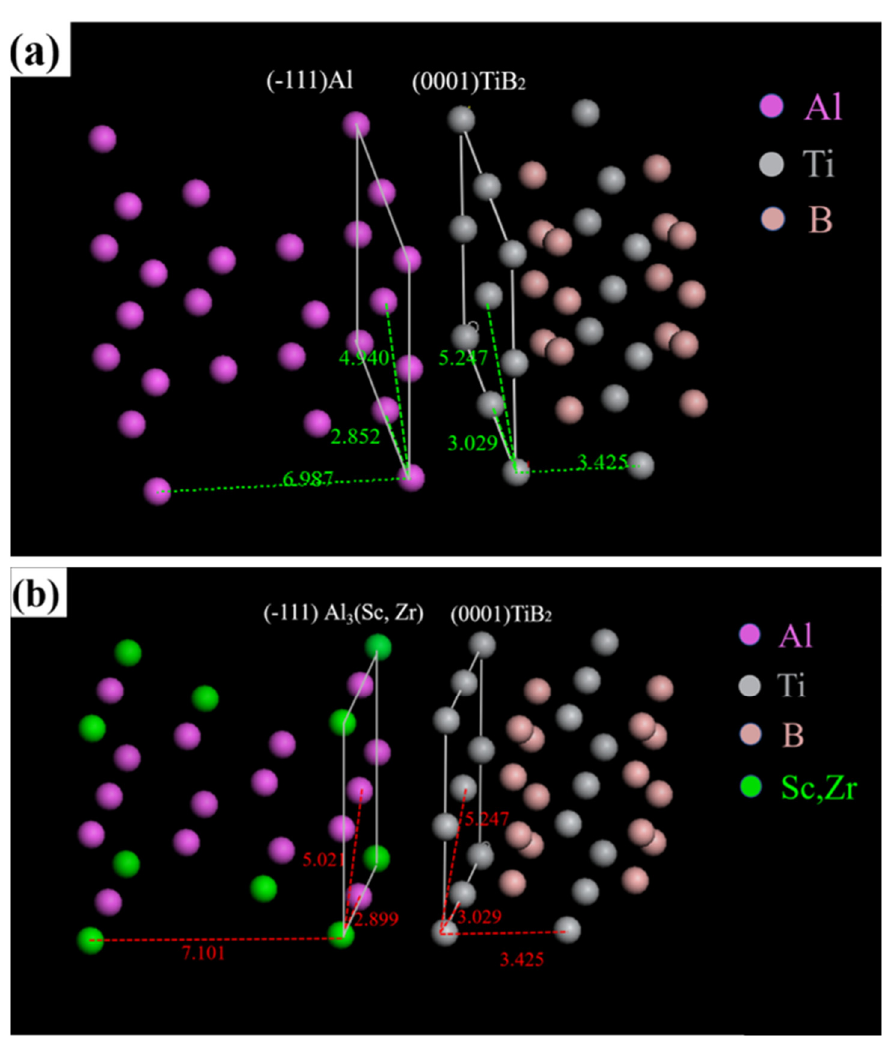
Figure 11. Crystal structure models of interface between TiB 2 and AlZnMgCu(Sc,Zr) matrix, ( a ) ( − 111)Al and (0001)TiB 2 , ( b ) ( − 111)Al 3 (Sc,Zr) and (0001)TiB 2 .